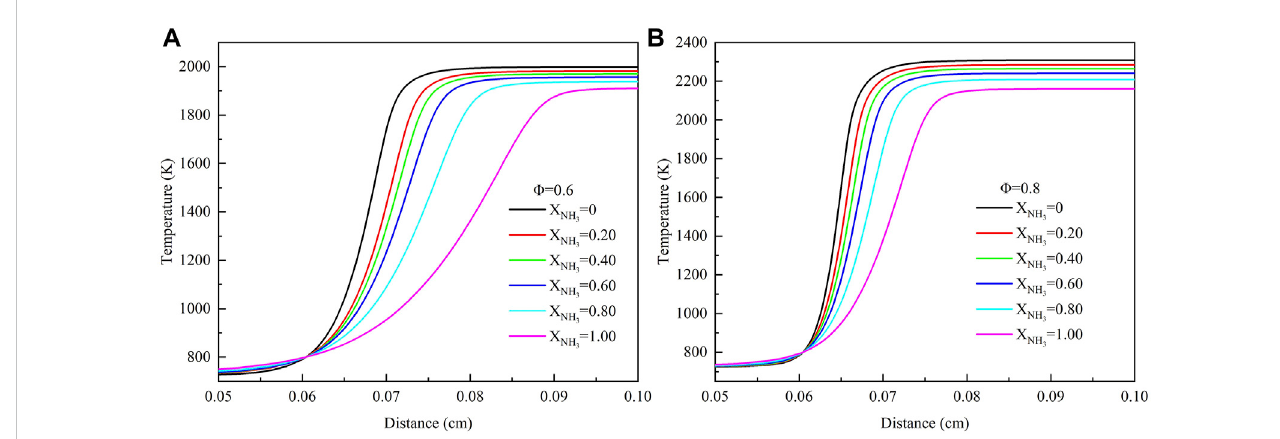
FIGURE 8 Mole fraction of temperature with different ammonia content: (A) Φ = .6; (B) Φ = .8. (T = 723 K, p = 16.5 atm).